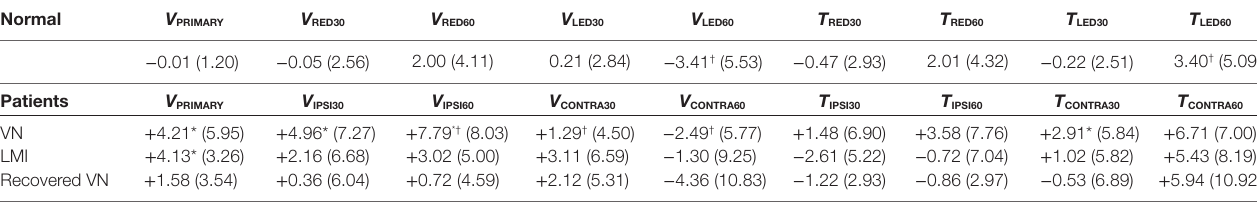
RED, head tilts with right ear down position; LED, head tilts with left ear down; IPSI, head tilts to the ipsilesional side; CONTRA, head tilts to the contralesional side; VN, vestibular neuritis; LMI, lateral medullary infarction. The values are presented as the mean (SD). In normal controls, a positive value of SVV indicates rightward tilt from the subject’s perspective. In patients, the SVV was defined positive when the tilt is toward the lesion side. The shift in SVV induced by head tilts (T value) was obtained by subtracting the SVV in the primary head position from the SVV in each head tilted position. In both normal controls and patients, T value was defined to be negative when the shift is in the opposite direction of head tilt. When the shift was in the same direction of head tilt, T value was defined to be positive. *Significantly different from controls. † Significantly different from the SVV in the primary head position.